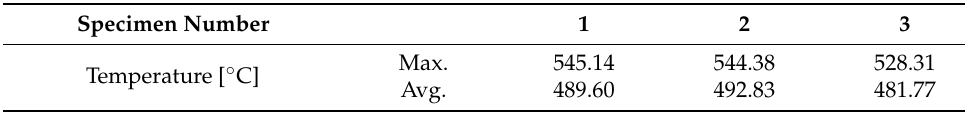
Figure 2. PSH schematic diagram and tube sample location. Table 2. Operating temperature according to pipe location.